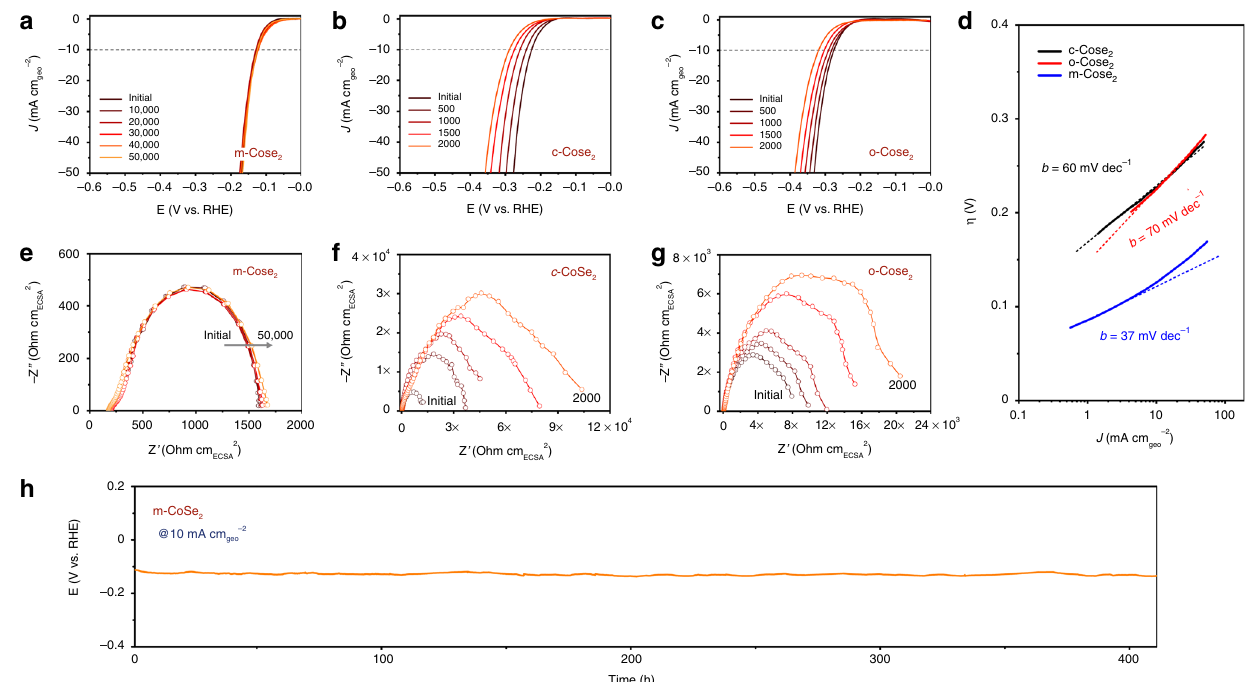
Fig. 3 Electrochemical stability of m-, c-, and o-CoSe 2 . a – c HER polarization curves of m-, c -, and o-CoSe 2 catalysts before and after different potential cycles, respectively. Catalyst loading: ~1.02 mg cm − 2 . Sweep rate: 2 mV s − 1 . d Tafel plots for m-, c - , and o-CoSe 2 catalysts derived from their initial polarization curves. e – g EIS Nyquist plots of the m-, c - , and o-CoSe 2 catalysts before and after different potential cycles, respectively. h Chronopotentiometry ( E ~ t ) recorded on m-CoSe 2 catalyst at the constant current density of 10 mA cm − 2 , exhibiting the exceptional long-term